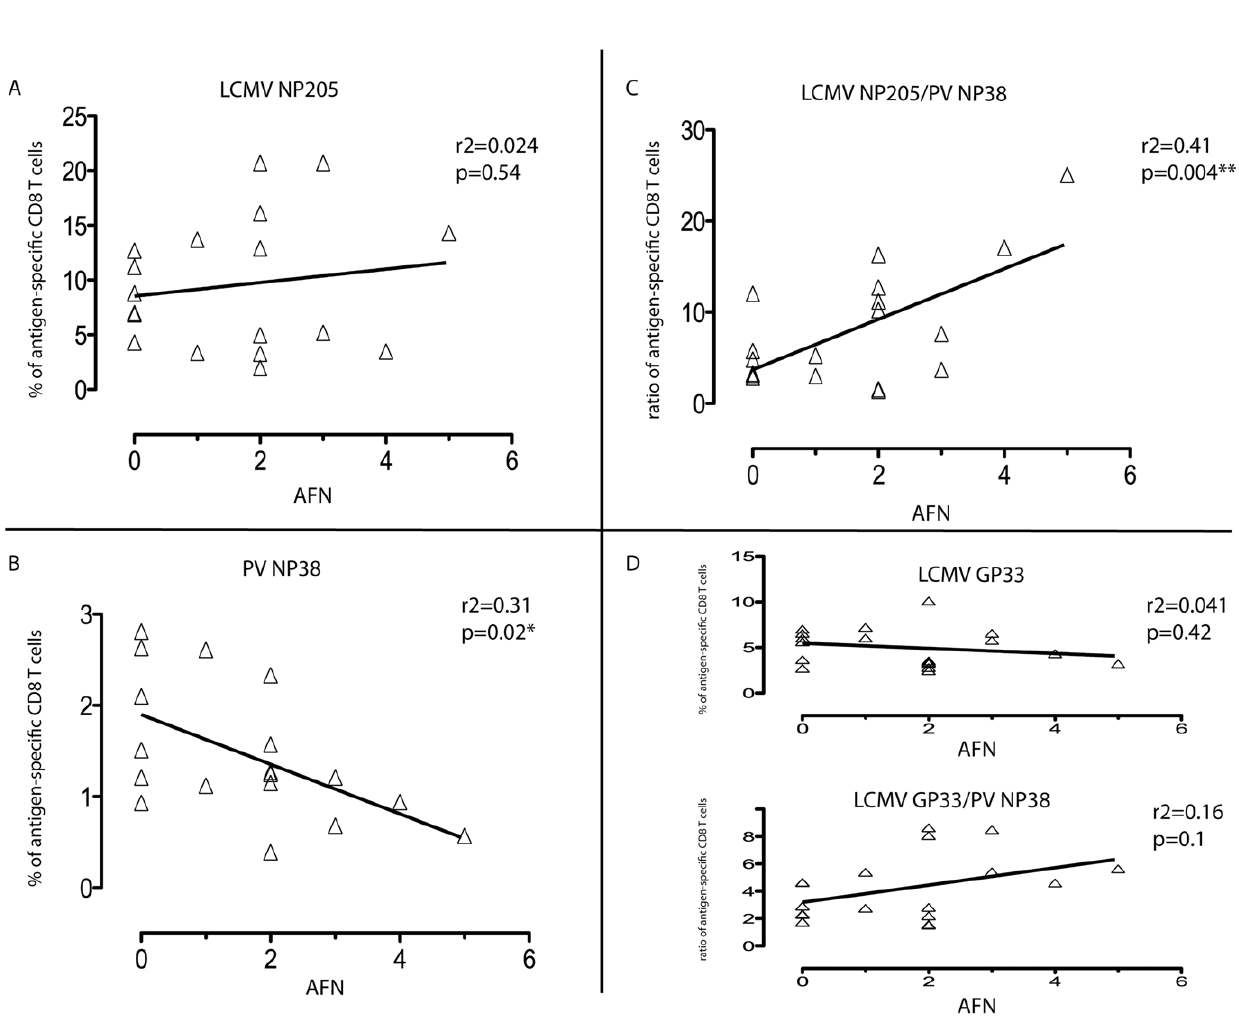
Figure 6. Correlation of frequencies of CD8 T cells in double-immune mice with pathology after PV re-challenge. Linear regression analyses comparing the frequencies of antigen-specific CD8 T cells in the (PV + WT LCMV) double immune mice with the severity of AFN following PV re-challenge. These represent data compiled from four independent experiments using LCMV Clone 13 virus. (A) LCMV NP205-specific CD8 T cell response. (B) PV NP38-specific CD8 T cell response. (C) Ratio of LCMV NP205 to PV NP38. (D) LCMV GP33 and the ratio of GP33/PV